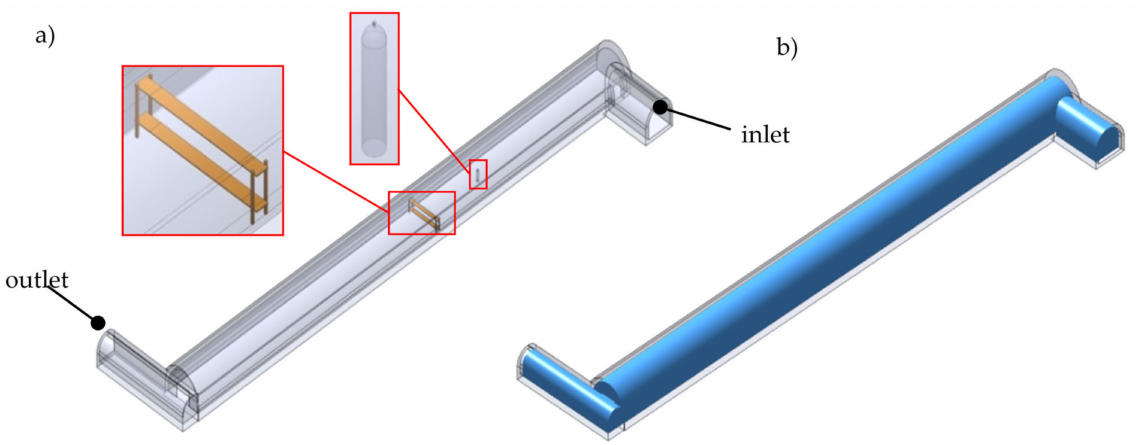
Figure 5. Geometric model of the tested excavation: ( a ) spatial model; ( b ) separated volume of the